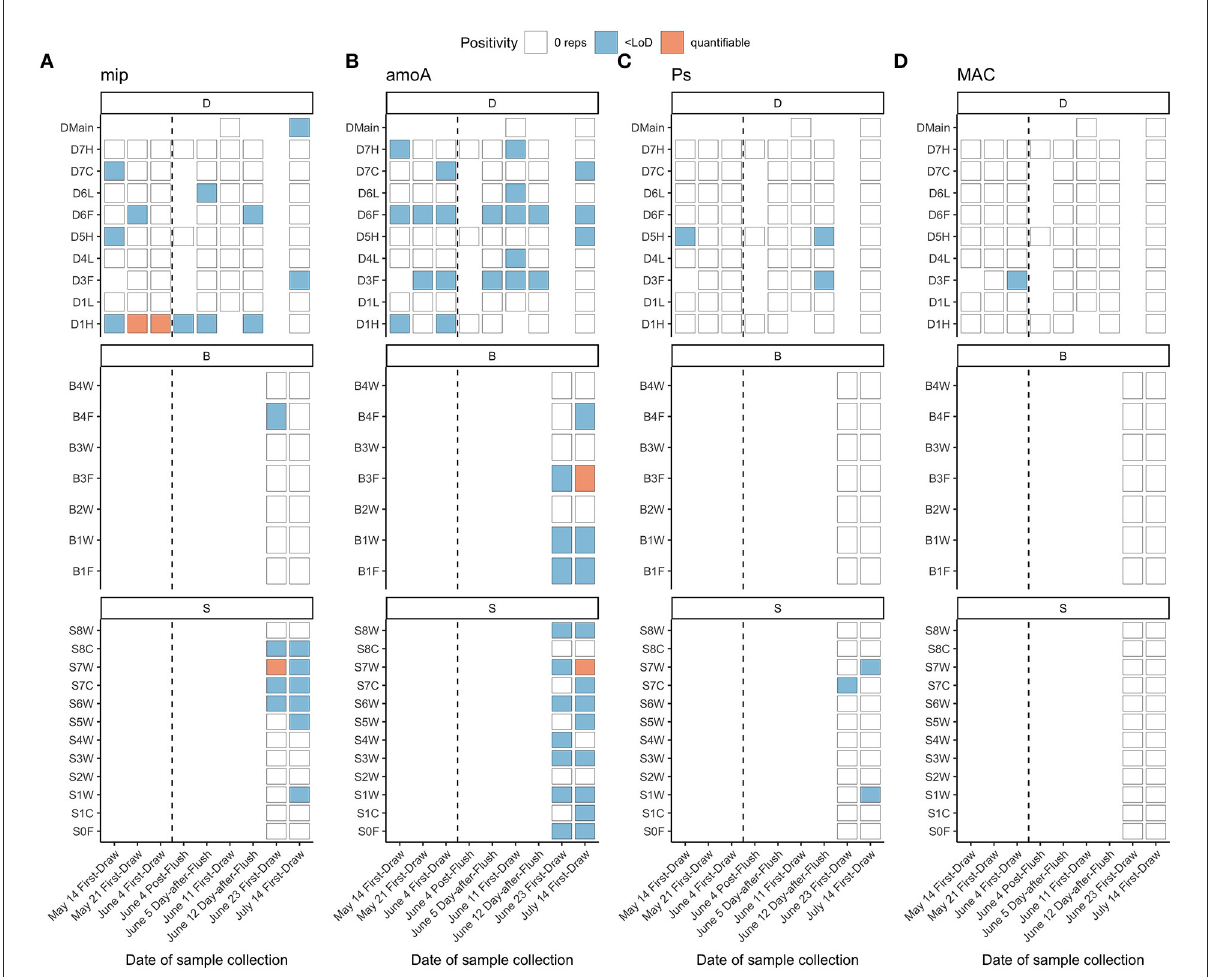
FIGURE7 qPCR detection of (A) L. pneumophila ( mip ), (B) ammonia-oxidizing bacteria ( amoA ), (C) P. aeruginosa ( opr L) and (D) MAC (MACF/MACR). Vertical dashed lines indicate a flushing event in building D separating two sample collection events on the same day. Sample S6W was positive for L. pneumophila via culture-based Legiolert on June 23, 2020. Fixture IDs are written as one letter indicating the building (D, B, S), followed by the floor number (0 to 7), followed by one letter indicating the fixture type (W, shower; L, laboratory faucet; F, drinking fountain; H, hot/mixed faucet; C, cold